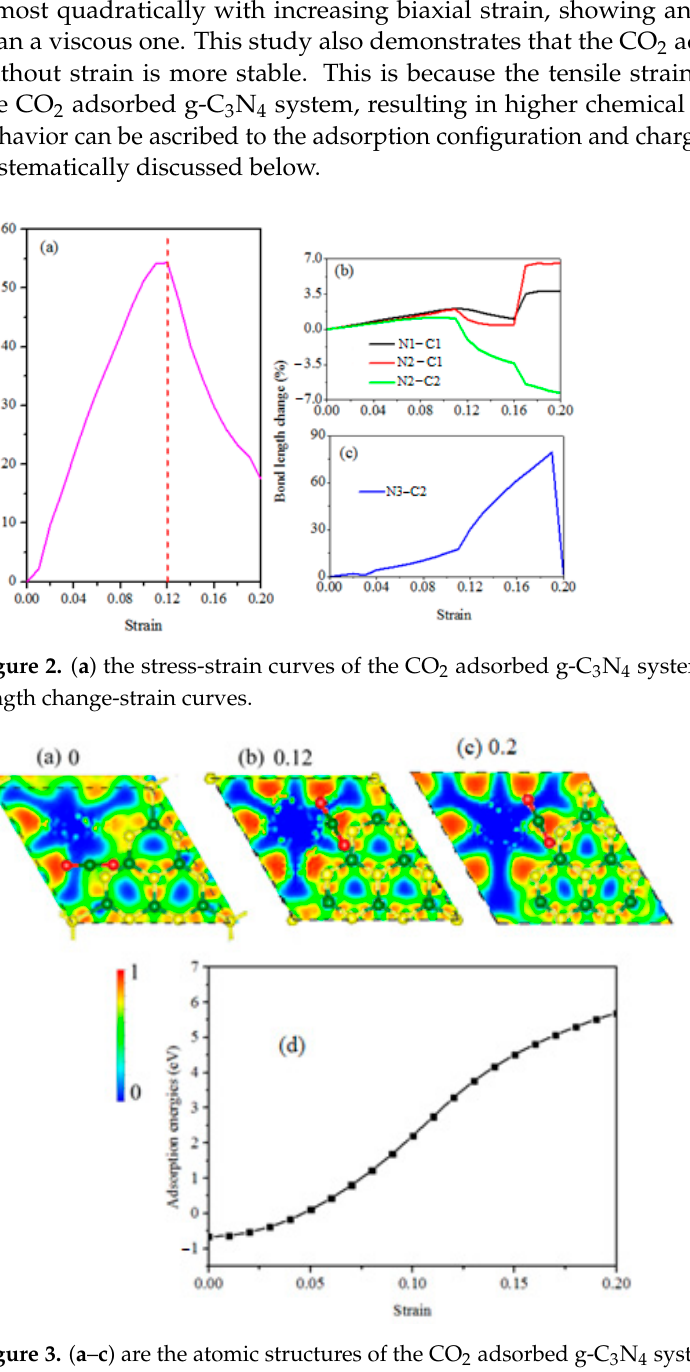
Figure 3. ( a – c ) are the atomic structures of the CO 2 adsorbed g-C 3 N 4 system at 0, 0.12 and 0.2 strain, respectively. Contours illustrate the electron localization function (ELF) within the unit-cell. ( d ) shows the adsorption energy-strain curve of the CO 2 adsorbed g-C 3 N 4 system.